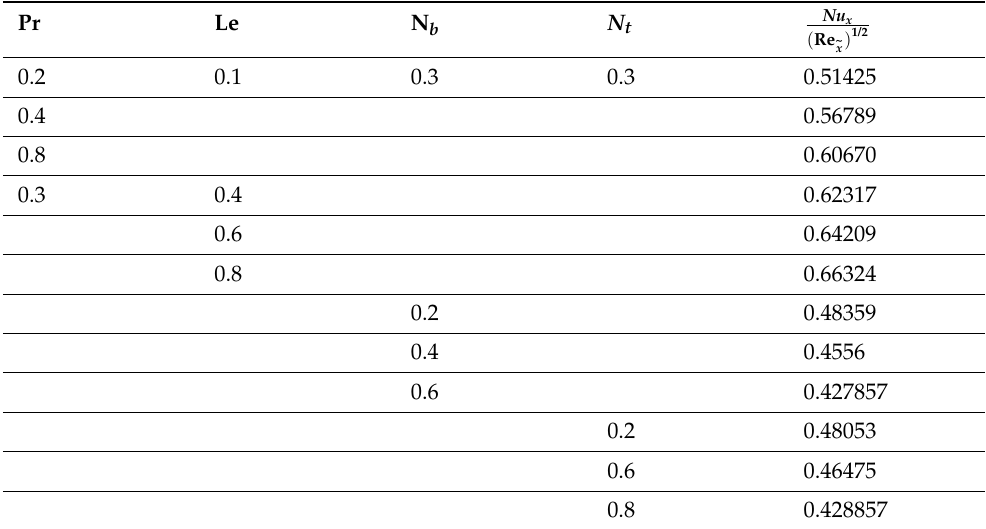
Table 1. Evaluation of Nusselt number at various governing parameters.